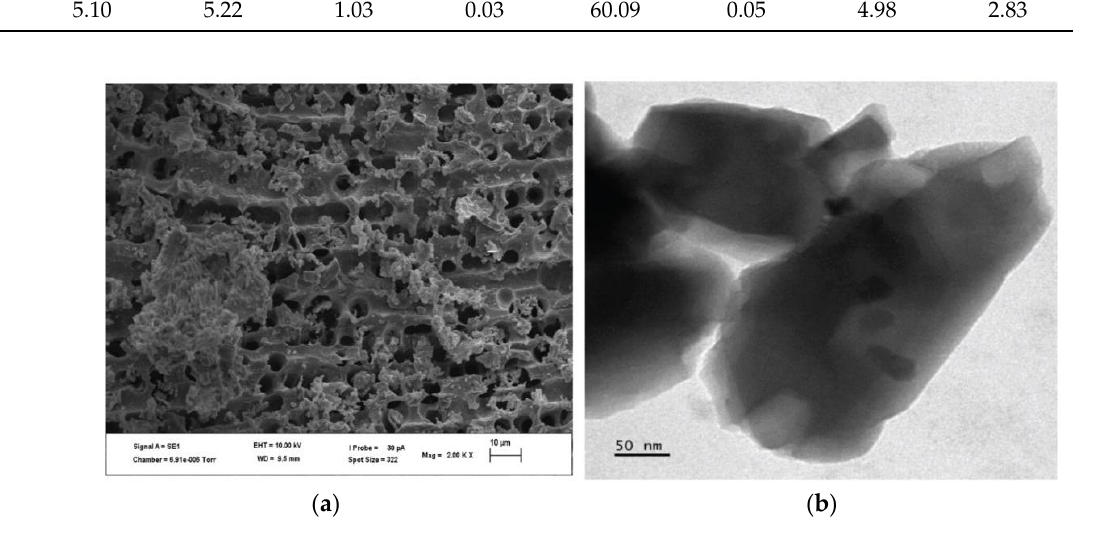
Figure 3. CHA micromorphology: ( a ) SEM magnified at 10 m and ( b ) TEM of CHA magnified at 50 nm [50].